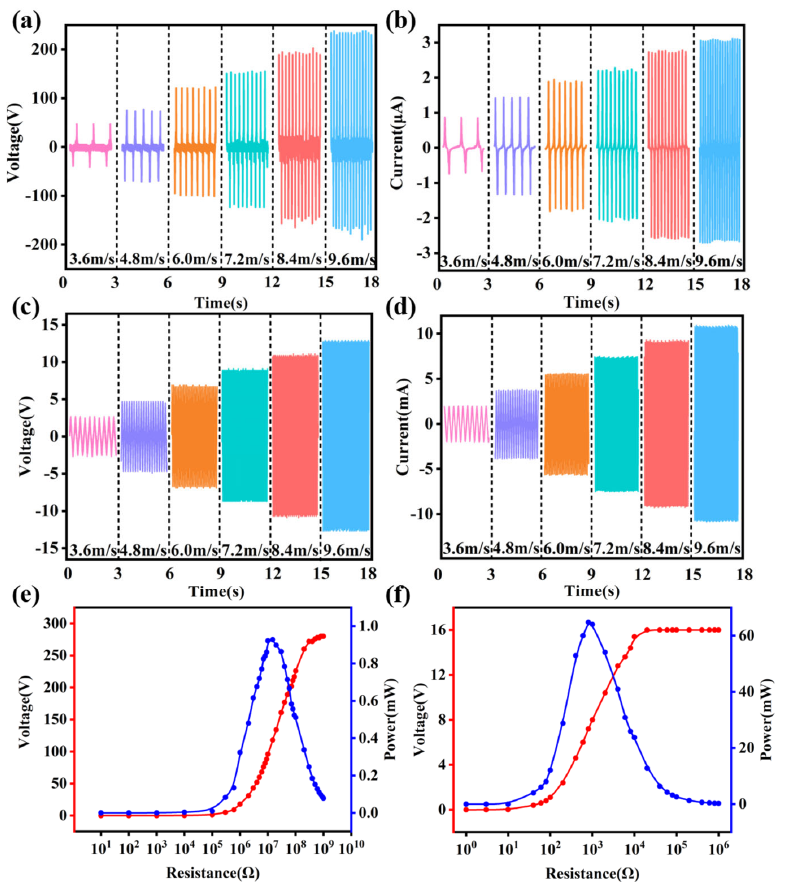
Figure 7. The output characteristics of TENG1 and EMG at different wind speeds: the Voc of ( a ) TENG1 and ( c ) EMG; the Isc of ( b ) TENG and ( d ) EMG; the output power of ( e ) TENG1 and ( f ) EMG at a wind speed of 9.6 m/s, with different external load resistances. The output voltages are obtained using an MSO oscilloscope, and the horizontal scanning time is set as 400 ms per